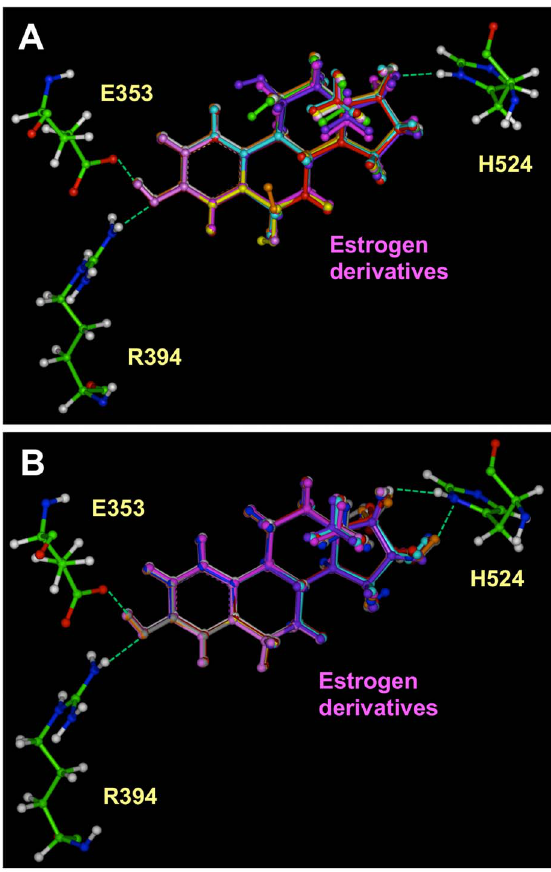
Figure 6. Interactions of B / C -ring (A) and D -ring derivatives (B) with ER a LBD determined by molecular docking. The green dashes indicate the hydrogen bonds formed. All the structures are shown in ball and stick. The amino acids were colored according to the atom type, i.e. green for carbon, red for oxygen, blue for nitrogen and white for hydrogen. Among the amino acids in the binding site, only E353, R394 and H524 are shown in this figure. E 2 was colored in white. The ligands were shown in the following different colors: in panel A , 6 a -OH-E 2 (yellow), 6 b -OH-E 2 (orange), 6-keto-E 2 (pink), 6-dehydro-E 2 (red), 7-dehydro-E 2 (magenta), 9(11)-dehydro-E 2 (light blue), 11 a -OH-E 2 (purple) and 11 b -OH-E 2 (green); in panel B , E 1 (magenta) estriol (16 a - OH-E 2 ) (yellow), 16 b -OH-E 2 (orange), 16-keto-E 2 (pink), 17 a -OH-E 2 (red), 15 a -OH-E 3 (dark blue), 16 a -OH-E 1 (light blue), 16-keto-E 1 (purple), 16 a - OH-E 2 -17 a (brown), 16 b -OH-E 2 -17 a (grey). Docking module. The D E binding value includes two components, namely, the van der Waals (VDW) interaction energy ( D E VDW ) and the Coulomb interaction energy ( i.e. , electrostatic interaction energy, D E Coulomb ). Hydrogen bond energy is included as part of the Coulomb interaction energy. The following equation 1 is commonly used to calculate the total interaction energy D E binding :